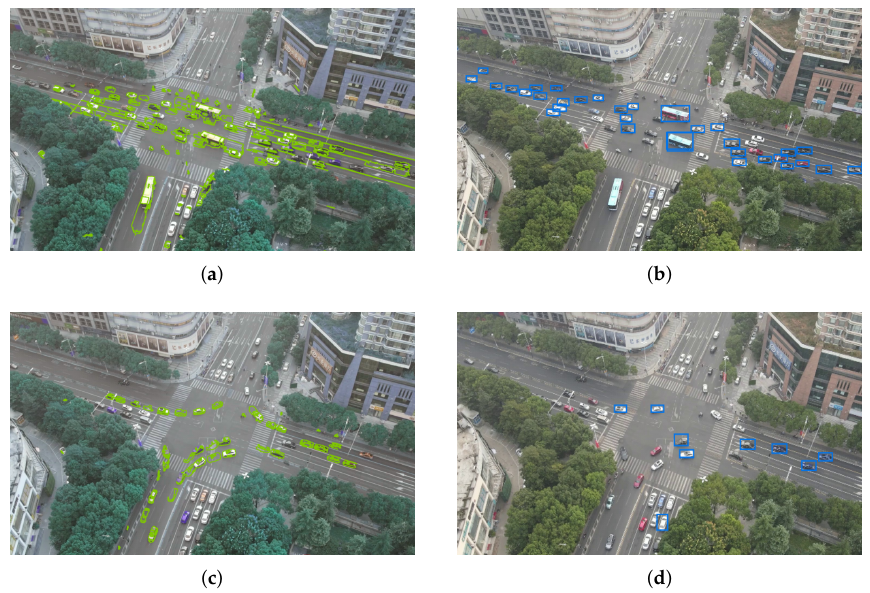
Figure 11. Comparison of DFA and yolov2. ( a ) DFA of frame3. ( b ) yolov2 of frame3. ( c ) DFA of frame47. ( d ) yolov2 of frame3.